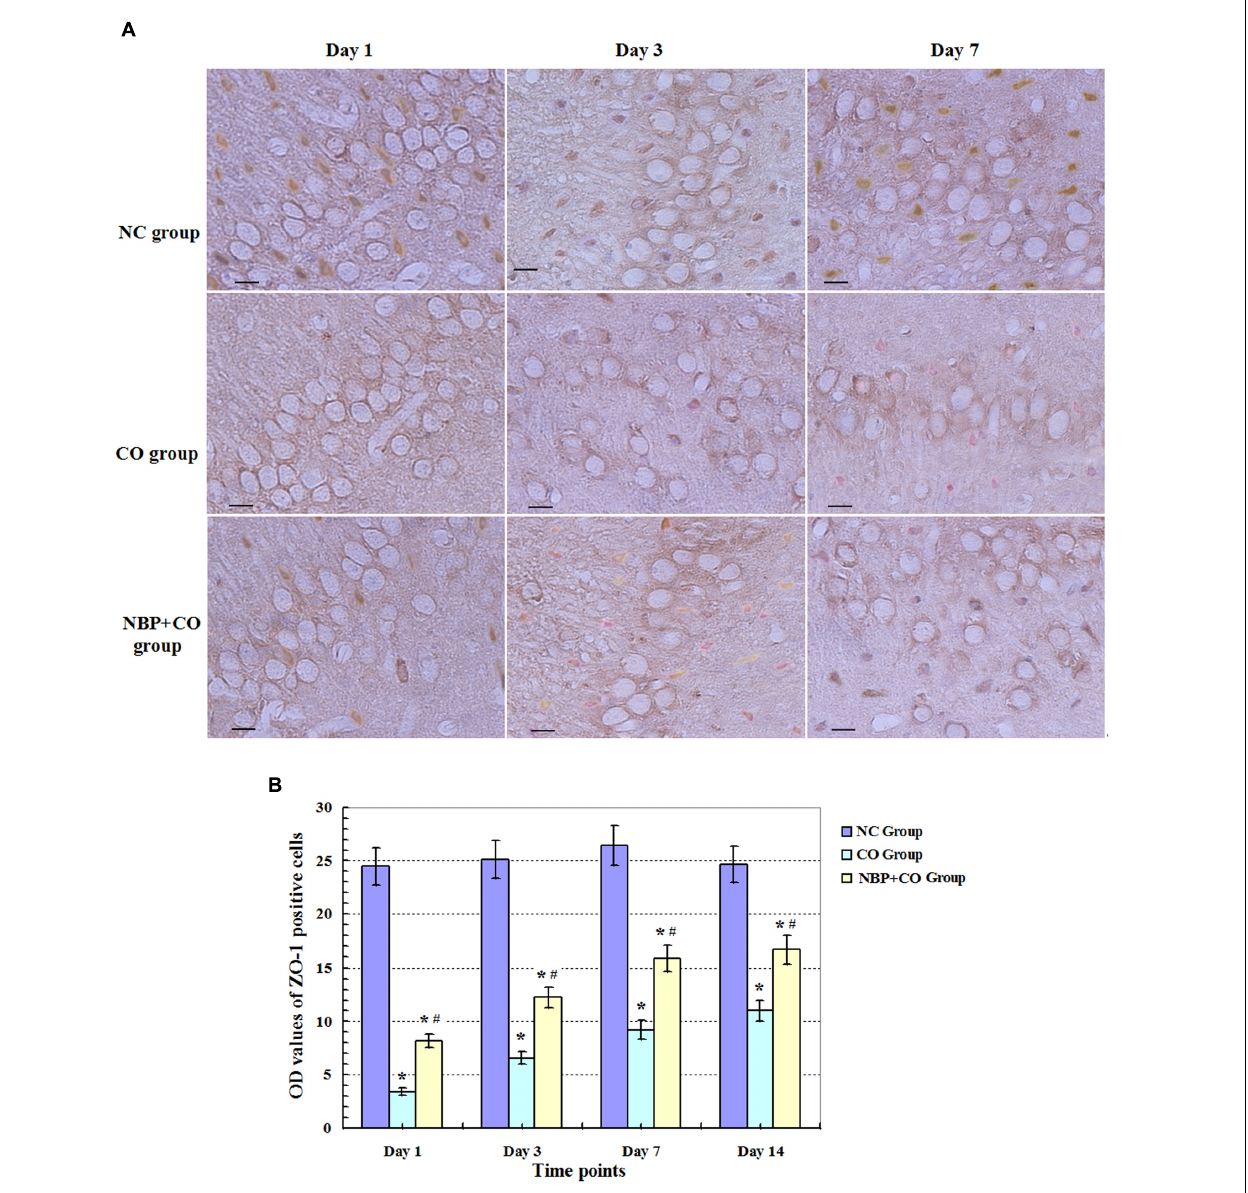
FIGURE 4 | Changes of ZO-1 protein in NC, CO, and NBP + CO groups. ZO-1 protein-positive cells were observed in rat brain tissues in NC group, whereas the expression of ZO-1 protein was notably reduced on day 1, and still maintained at lower levels between day 3 and day 7 for CO poisoning subjects. However, the amount of ZO-1 positive cells was elevated in NBP treatment rats compared to that in CO group at the same time point ( n = 4, P < 0.05). (A) The expressions of ZO-1 positive cells in each group; (B) The OD value alterations of ZO-1 positive cells among different groups ( n = 4). Scale bar represents 30 µ m. ∗ Compared with NC group, P < 0.05; # compared with CO group at the same time point, P < 0.05 ( F = 15.516 ∼